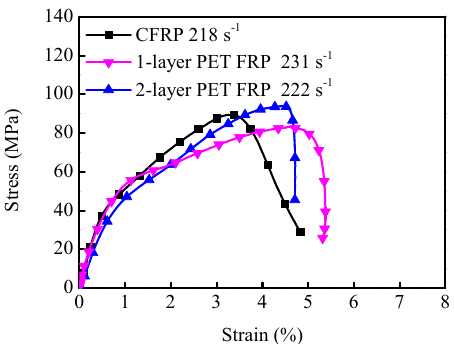
Figure 8. Comparison of the dynamic compressive stress–strain curves of the specimen at a strain rate of around 220 s −1 .